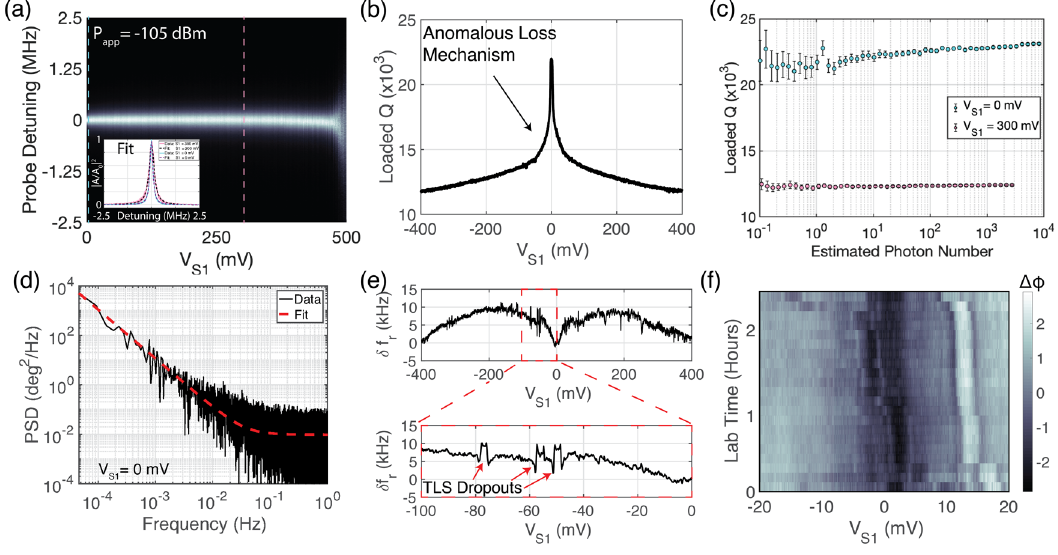
Fig. 4 TiN resonator characterization. a Measurement of the resonator fundamental transmission spectra as a function of gate voltage. Inset: extracted Lorentzian fi ts to the teal and pink traces at V S1 = 0 mV and V S1 = 300 mV, respectively. b Extracted loaded quality factor as a function of gate voltage showing an anomalous decrease in the loaded quality factor upon voltage biasing the center pin. A narrow plateau in Q L occurs between V S 1 = ± 2 mV where the additional loss is less than the coupling quality factor. c Power dependence of the loaded quality factor at 0 mV and 300 mV center pin bias. We extract a single photon internal quality factor of Q i ≈ 3 × 10 5 consistent with radiative losses from the large CPW geometry 56 . We estimate degradation of the internal quality factor to Q i ≈ 3 × 10 4 at V S1 = 300 mV. Error bars are the 95% con fi dence intervals of the fi t extracted Q L . d Phase noise power spectral density of the resonator with V S1 = 0 mV by probing the cavity on resonance with the dots empty. We extract a 1/ f β with β = 1.98 noise spectrum in the phase noise for frequencies below 0.1 Hz. e Upper: Resonator frequency shift ( δ f r = f r ( V S1 = 0) − f r ( V S1 )) as a function of voltage bias on the cavity pin. We observe a nonmonotonic modulation in the center frequency. Lower: Zoom-in of a bias region in which multiple TLS-cavity interactions are observed. f Spectral motion of two TLS interacting with the TiN resonator over several